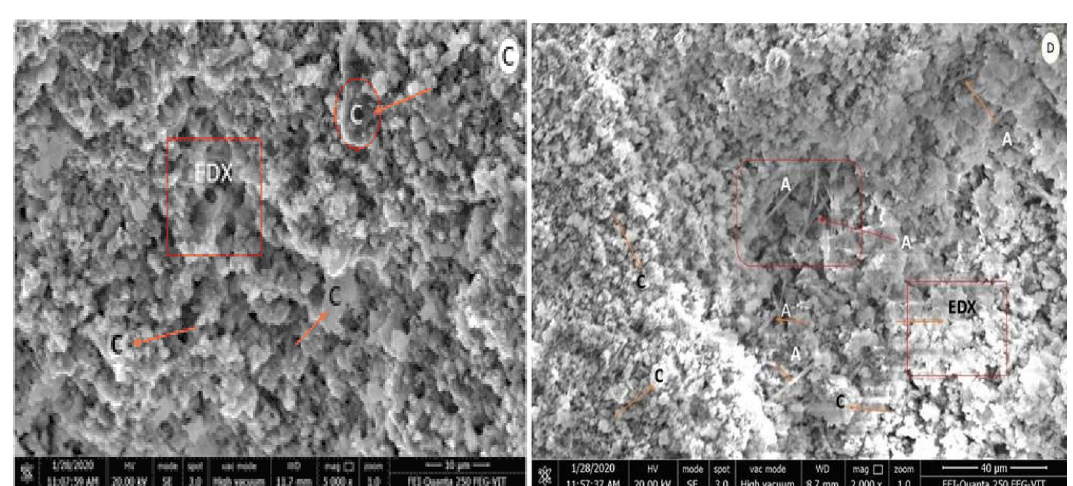
Figure 10. FESEM-EDX Images of modified organic lime paste with calcite and acicular aragonite crystals ( c ). Palm jaggery lime paste ( d ). Aloe vera lime paste.